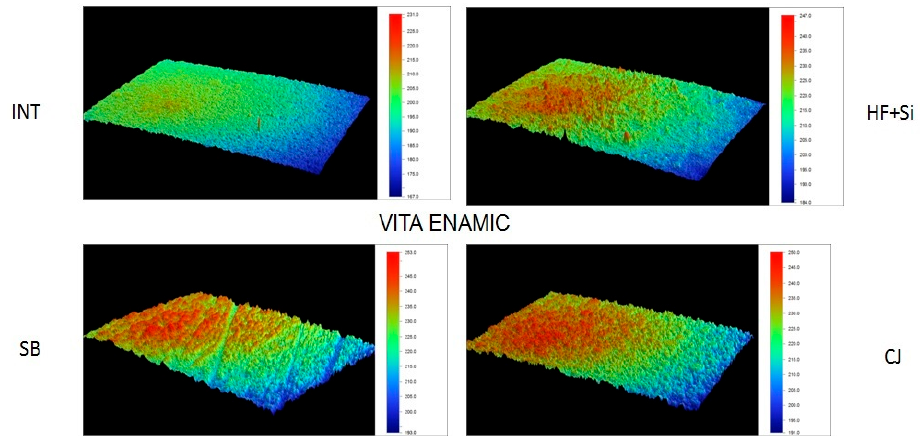
Figure 5. Representative 3D topographic surface maps of Brilliant Crios (×20 magnification).